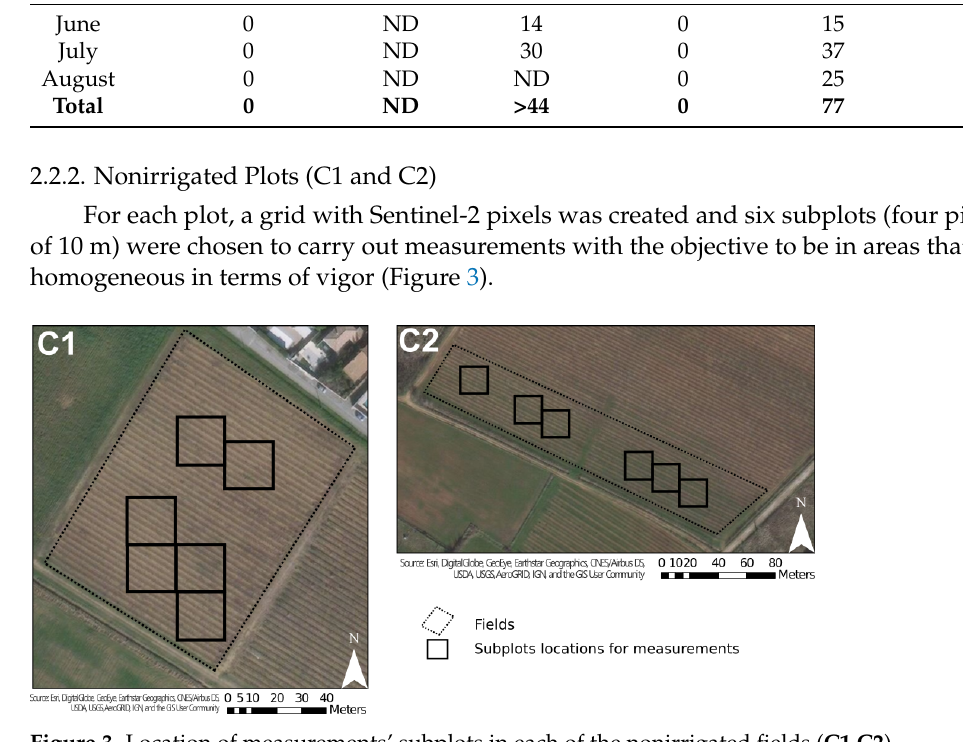
Figure 3. Location of measurements’ subplots in each of the nonirrigated fields ( C1 , C2